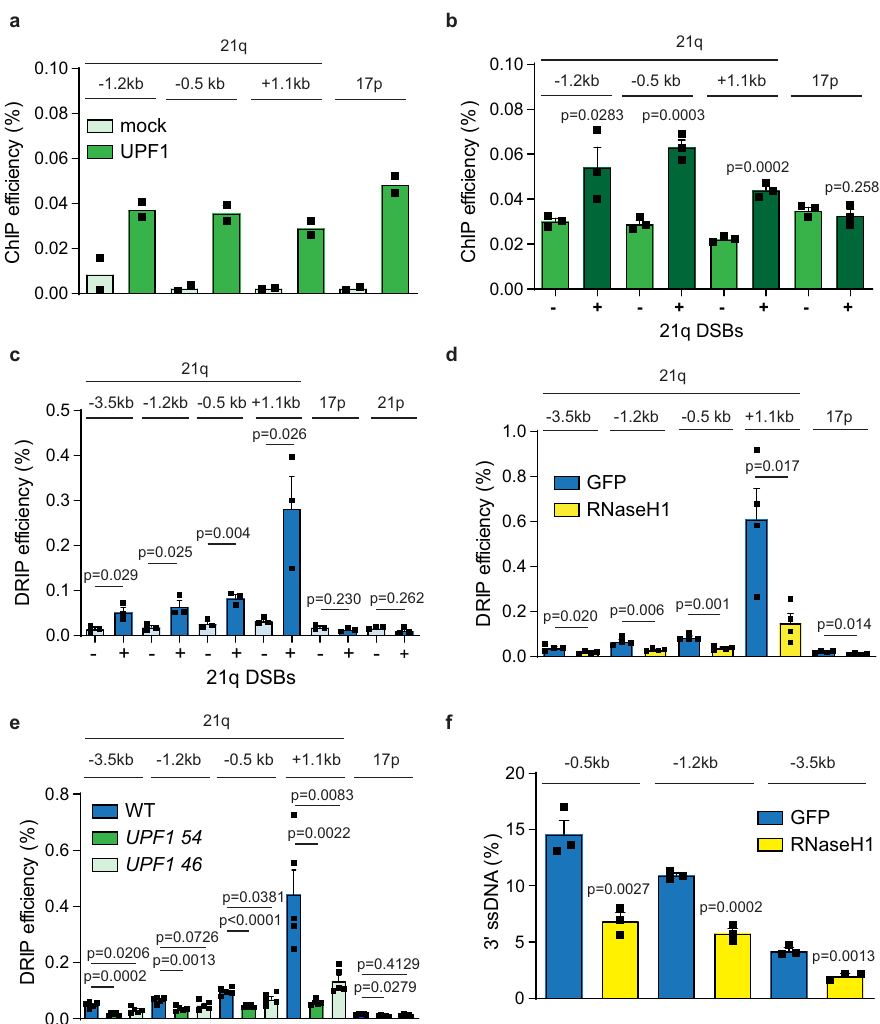
Fig. 5 UPF1 promotes DNA-RNA hybrid formation at sub-telomeric DSBs. a , b ChIP analysis of UPF1 binding to sub-telomeres with or without DSB induction (at 8 h after TALEN nucleofection). Data plotted are mean + SEM ( n = 2 for a , n = 3 for b ). p values were obtained using Student ’ s t -test (unpaired one-tailed, equal variance). c – e DRIP analysis showing the levels of DNA – RNA hybrids at the indicated loci in RPE1 WT cells in the presence ( + ) or absence ( − ) of sub-telomeric DSBs induction ( c ), RPE1 WT cells expressing RNaseH1 or GFP control ( d ), and RPE1 WT or UPF1 KO cells ( e ) at 10 h after TALEN nucleofection. Data plotted are mean + SEM ( n = 3 for c , d n = 5 for e ). p values were obtained using Student ’ s t -test (unpaired two-tailed, equal variance). f QAOS analysis in RPE1 WT cells expressing RNaseH1 or GFP control at 10 h after TALEN nucleofection. Data plotted are mean + SEM ( n = 3). p values were obtained as described in Fig. 3a. The n values indicate the number of independent experiments in all